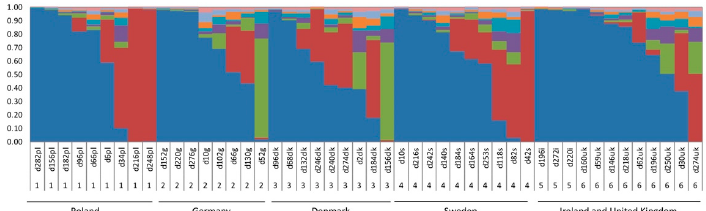
Figure 4. PCA of the plastome data. Axis one accounts for 14.2% of the variation and axis two for 5.6% of the variation. Some weak pattern can be seen relating to the geographical origin of samples. For example, samples from Ireland and UK are more common in the central region of the plot and Polish samples are only found in the lower region of the plot.